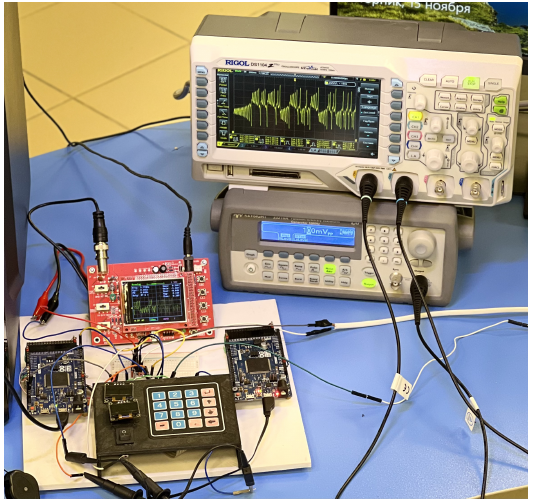
Figure 5. Photo of the chaotic communication test bench. Below, one can see the program code describing the transmitter and receiver chaotic oscillators for the Arduino